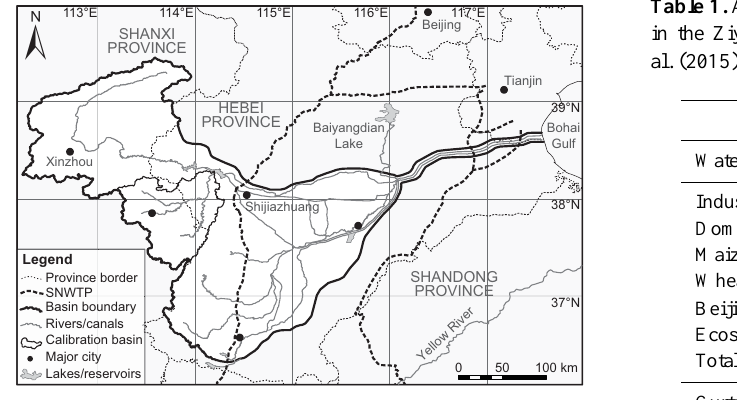
Figure 1. The Ziya River basin. Watershed and rivers automatically delineated from a digital elevation map (USGS, 2004) and manu- ally verified and corrected with Google Earth (Google Inc., 2013). The SNWTP routes (central and eastern) were sketched in Google Earth and verified with field observations. Provincial boundaries from NGCC (2009).